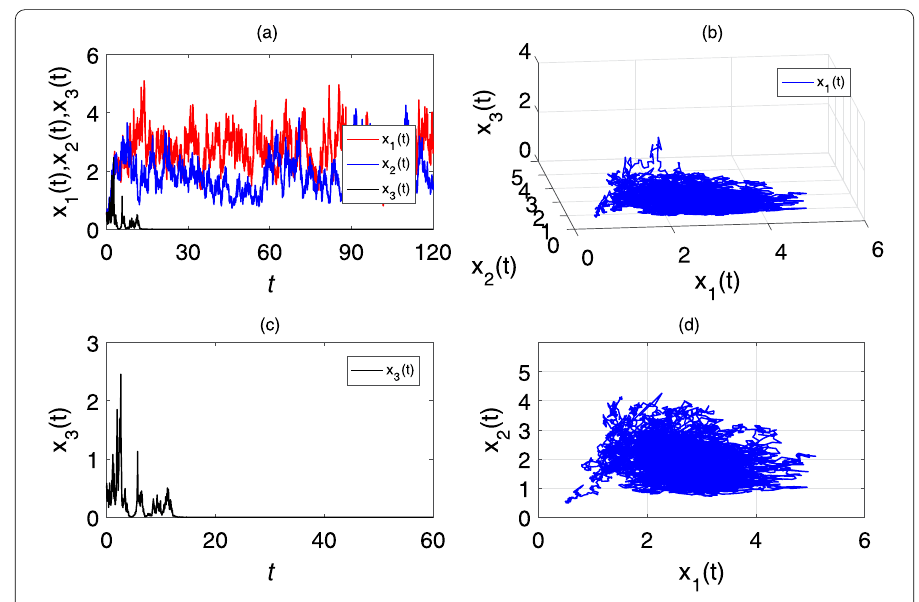
Figure 5 Extinction of the predator population x 3 ( t ) of system (2). (a) Time sequence diagram and (b) the phase portrait of system (2).( x 1 (0), x 2 (0), x 3 (0)) = (0.5,0.5,0.5), σ 2 1 ( t ) = σ 2 2 ( t ) = 0.1 + 0.04sin t , σ 2 3 ( t ) = 2.2 + 0.04sin t